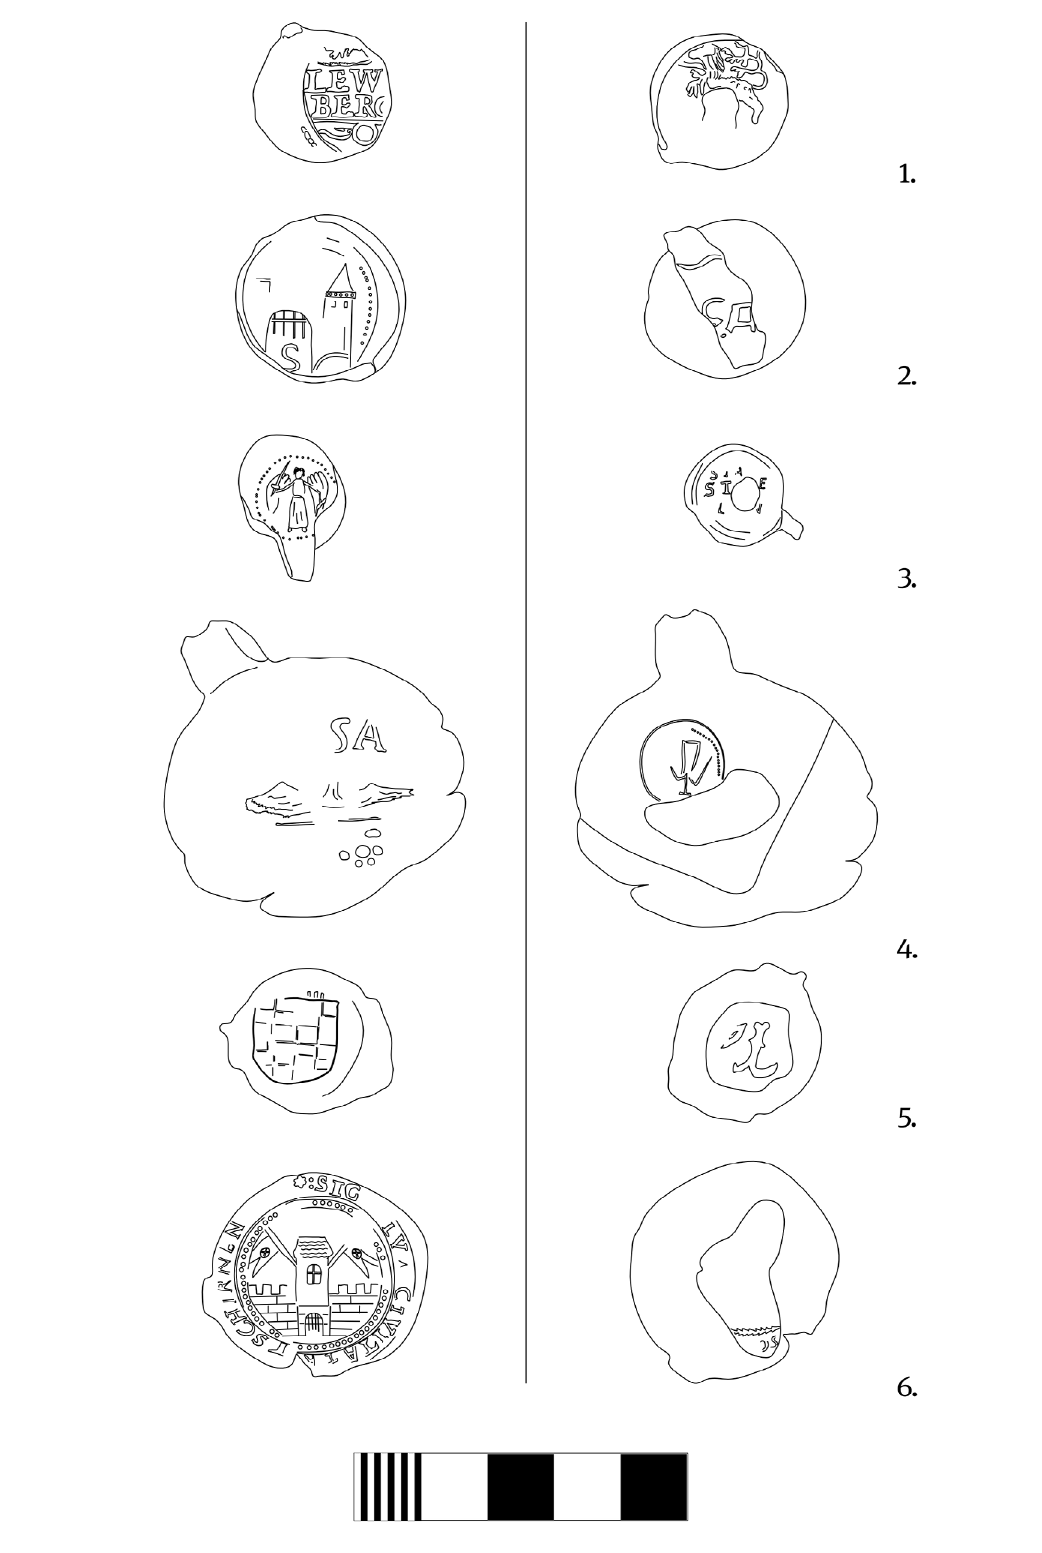
Figure 30. Lead seals originated from Lwówek Śląski (1), Żagań (2), Strzelin (3), Nysa (4), Kożuchów (5), Czernina